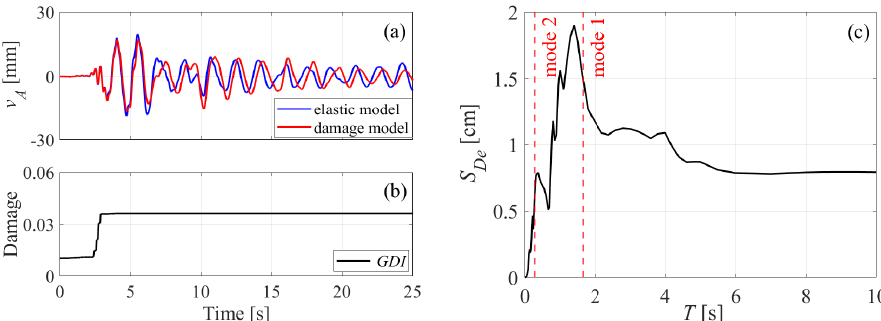
Figure 18. Earthquake CLO station: ( a ) elastic and damage responses of the equivalent pier, ( b ) evolution of the GDI , ( c ) elastic displacement